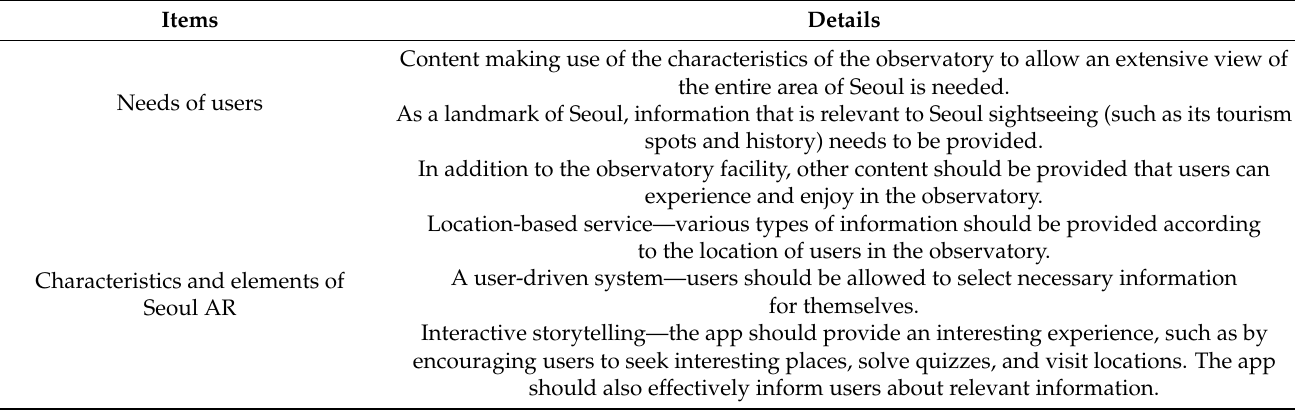
Table 2. Design elements defined for Seoul